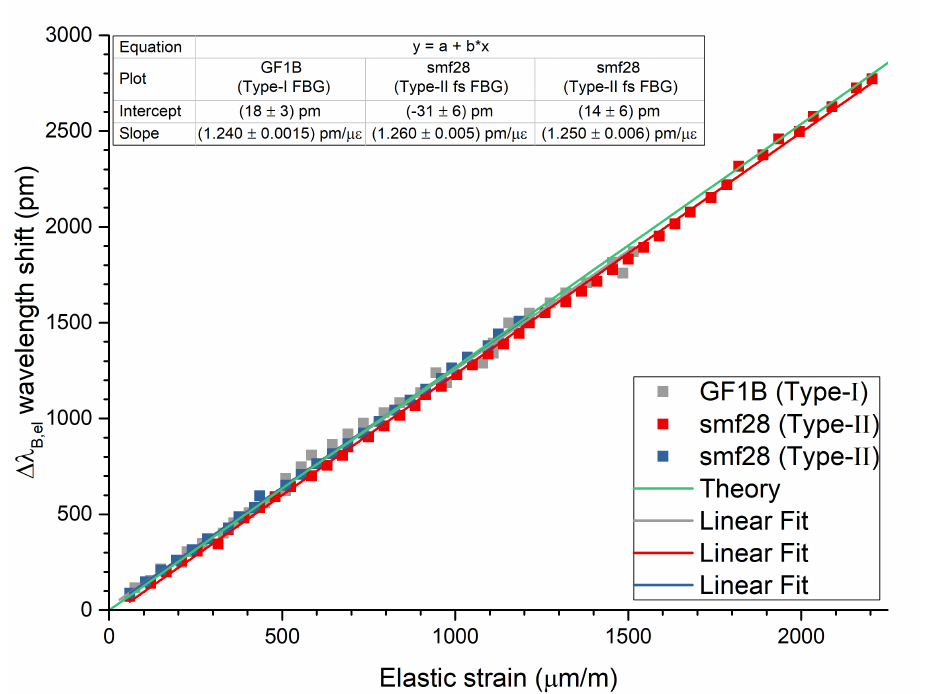
Figure 8. Elastic part of the wavelength shift of each FBG during tensile tests. Linear regressions (solid lines) were applied to the data points (solid squares). The theoretical wavelength shift is plotted as a solid green line as well and shows good agreement with the